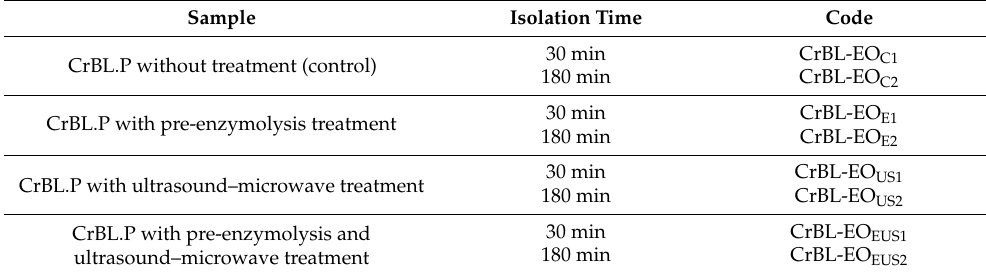
Table 1. Codes for the treatments subject to essential oil